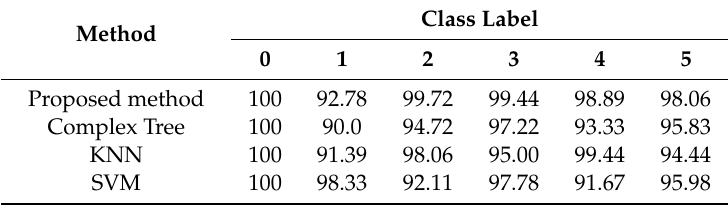
Figure 6. The fault diagnosis confusion matrix. Table 4. The comparison of diagnosis accuracy of different models (%).